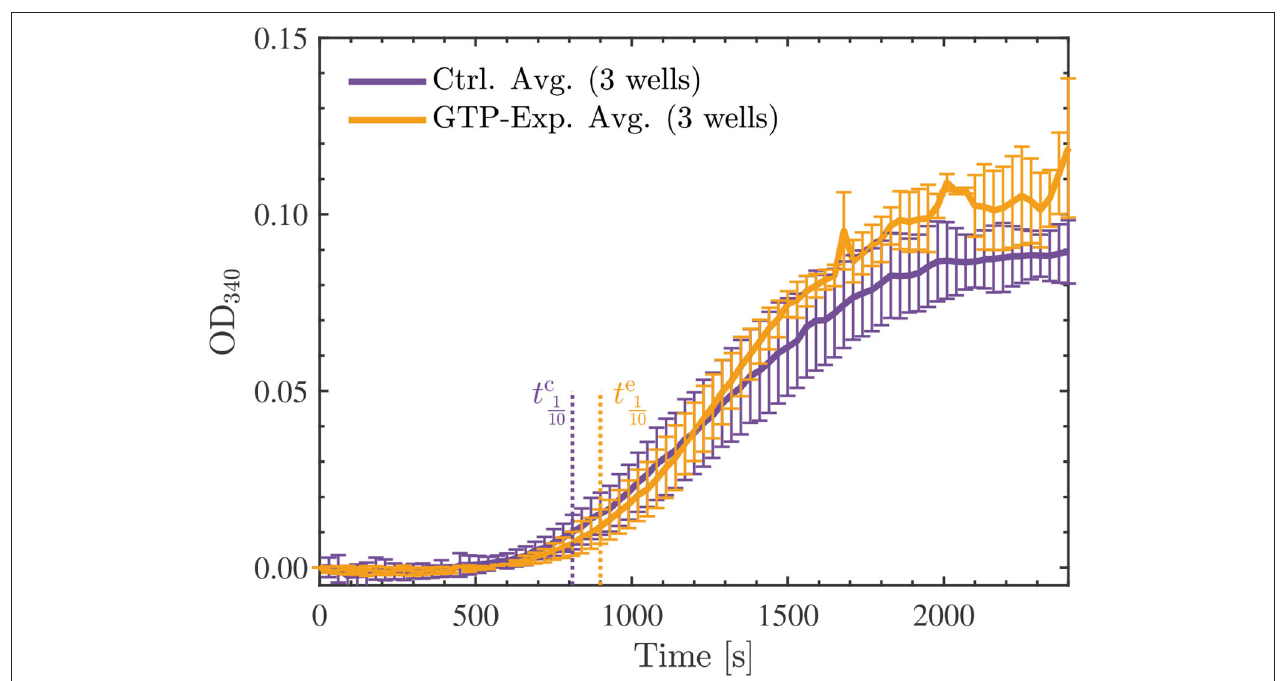
FIGURE 12 | Average optical density results of absorbance measurements performed at 340 nm, every 30 s for 40 min, on the 22.7 µ M tubulin samples reconstituted by the standard procedure (control—purple) or with GTP exposed to the Vielight LED (yellow). The GTP exposure was performed for 30 min at 4 ◦ C using 10 µ l of stock GTP solution (100 mM) suspended in DI water. The tenth times of t c 1 / 10 ≃ 810 s and t e 1 / 10 ≃ 900 s calculated for the control and exposed curves, respectively, are overlayed as the dotted vertical lines shown. The data presented was collected in N = 1 independent replicate